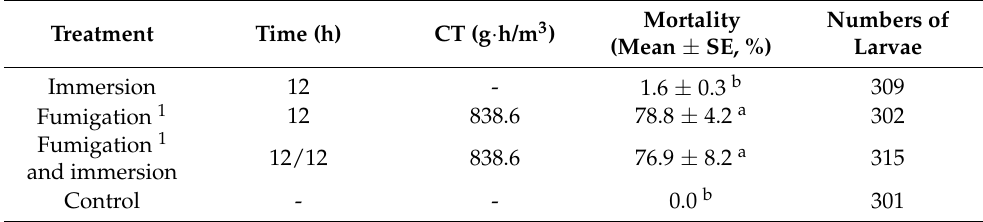
Table 3. Effects of fumigation and immersion on Curculio sikkimensis at 15 ◦ C (filling ratio = 2.5%).